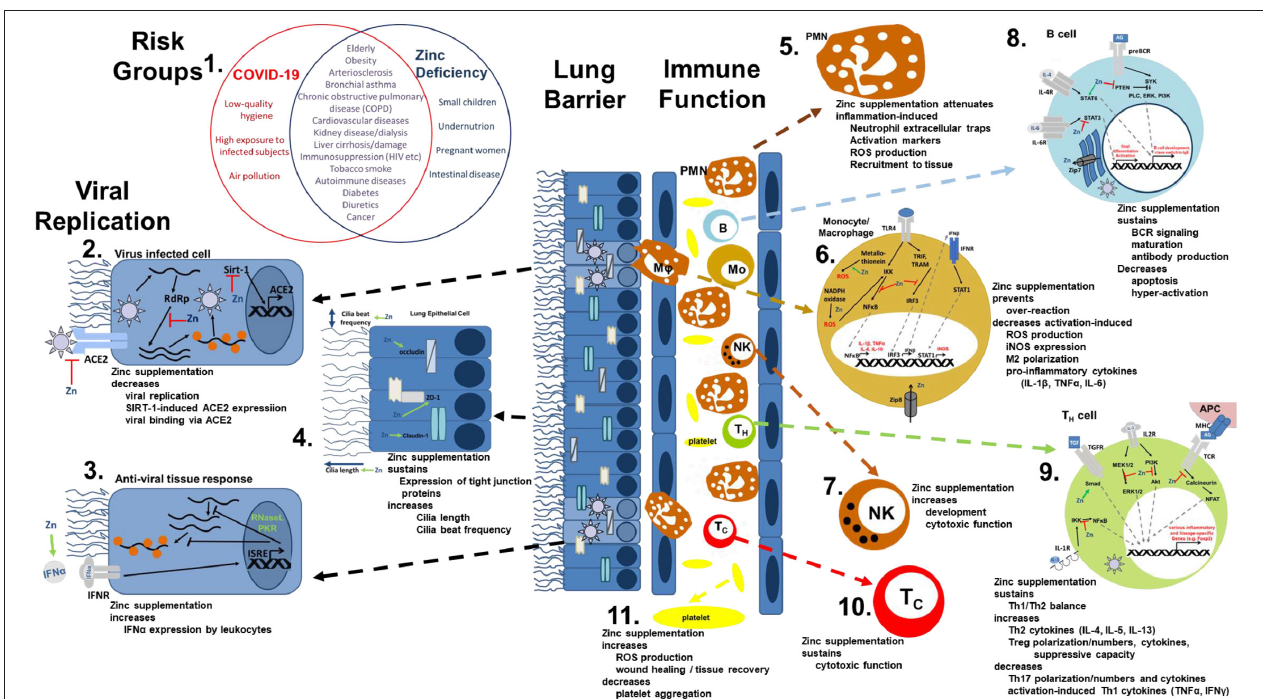
FIGURE 1 | Viral mechanism of COVID-19 and how they might be opposed by zinc data. (1) There is an impressive intersection of known risk factors for zinc deficiency (blue circle) and the predisposition for a severe COVID-19 infection (red circle). (2,3) Zinc (Zn) supplementation might already prevent the viral entry and also suppresses its replication, while it supports the anti-viral response of the host cells. (4) As zinc is known to increase ciliary length and movements and also sustains tissue integrity, entrance of the virus is impeded. (5 − 10) The importance of zinc on the development and function of the immune cells is manifold. It should be underlined, that zinc’s effects should not generally be described as activating or inhibiting, as zinc in various cases normalizes overshooting immune reactions and balances the ratios of the various immune cell types. Zinc thus prevents for example that high levels of inflammatory mediators including reactive oxygen and nitrogen species destroy the host tissue. (11) On first view it appears contradicting, that zinc increases activation induced production of reactive oxygen species in platelets, while it is generally considered as anti-oxidative. However, in case of platelets, up to a certain threshold, ROS production is essential, as it can prevent the formation of platelet aggregates. In summary, zinc therefore might be able to prevent vascular complications observed in COVID-19 patients. Details for each point can be found in the text. ACE2, angiotensin converting enzyme 2; AG, antigen; IFN, interferon; IFNR, interferon receptor; ISRE, interferon-sensitive response element; APC, antigen presenting cell; IKK, I κ B kinase; IL, interleukin; iNOS, inducible nitric oxide synthase; IRF3, IFN regulatory factor 3; MHC, major histocompatibility complex; MEK1/2, mitogen-activated protein kinase kinase 1/2; NADPH oxidase, nicotinamide adenine dinucleotide phosphate oxidase; NFAT, nuclear factor of activated T-cells; NF- κ B, nuclear factor kappa B; PKR, protein kinase R; Akt, protein kinase B; PI3K, phosphatidylinositol-3 kinases; ROS, reactive oxygen species; RdRP, RNA-dependent RNA polymerase; RNase L, ribonuclease L; Sirt-, Sirtuin 1; STAT, signal transducer and activators of transcription; TCR, T cell receptor; Tc, cytotoxic T cell; TH, helper T cell; TGF, transforming growth factor; TRAM, TRIF-related adaptor molecule; TRIF, TIR-domain-containing adapter-inducing interferon- β ; TLR, toll-like receptor; TNF, tumor necrosis factor; Zip, Zrt- and Irt-like protein; ZO-1, zona